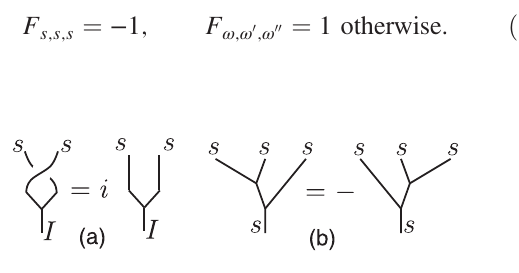
FIG. 3. Braiding and fusion statistics of the semion theory. (a) The exchange of two semions leads to a phase factor of i . (b) The two ways of fusing three semions differ by a